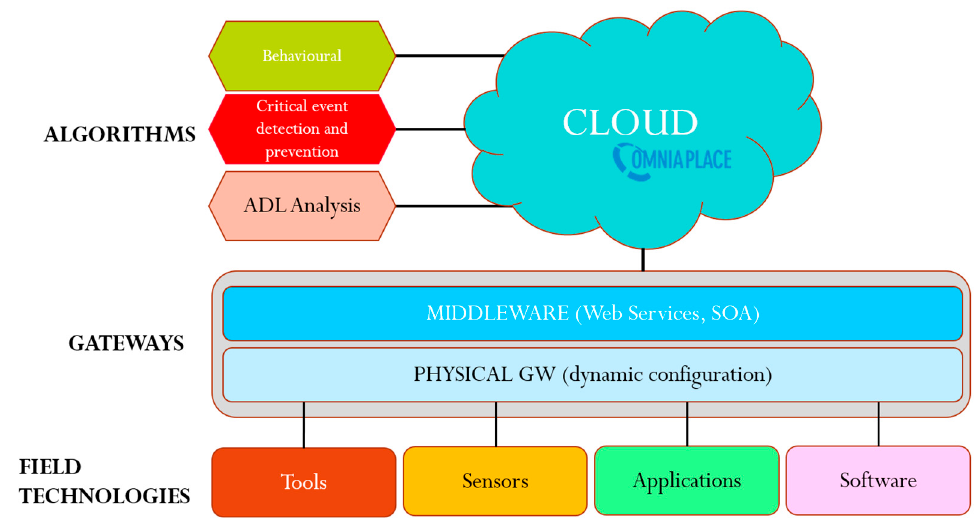
Figure 1. The AA@H Logical System Architecture.